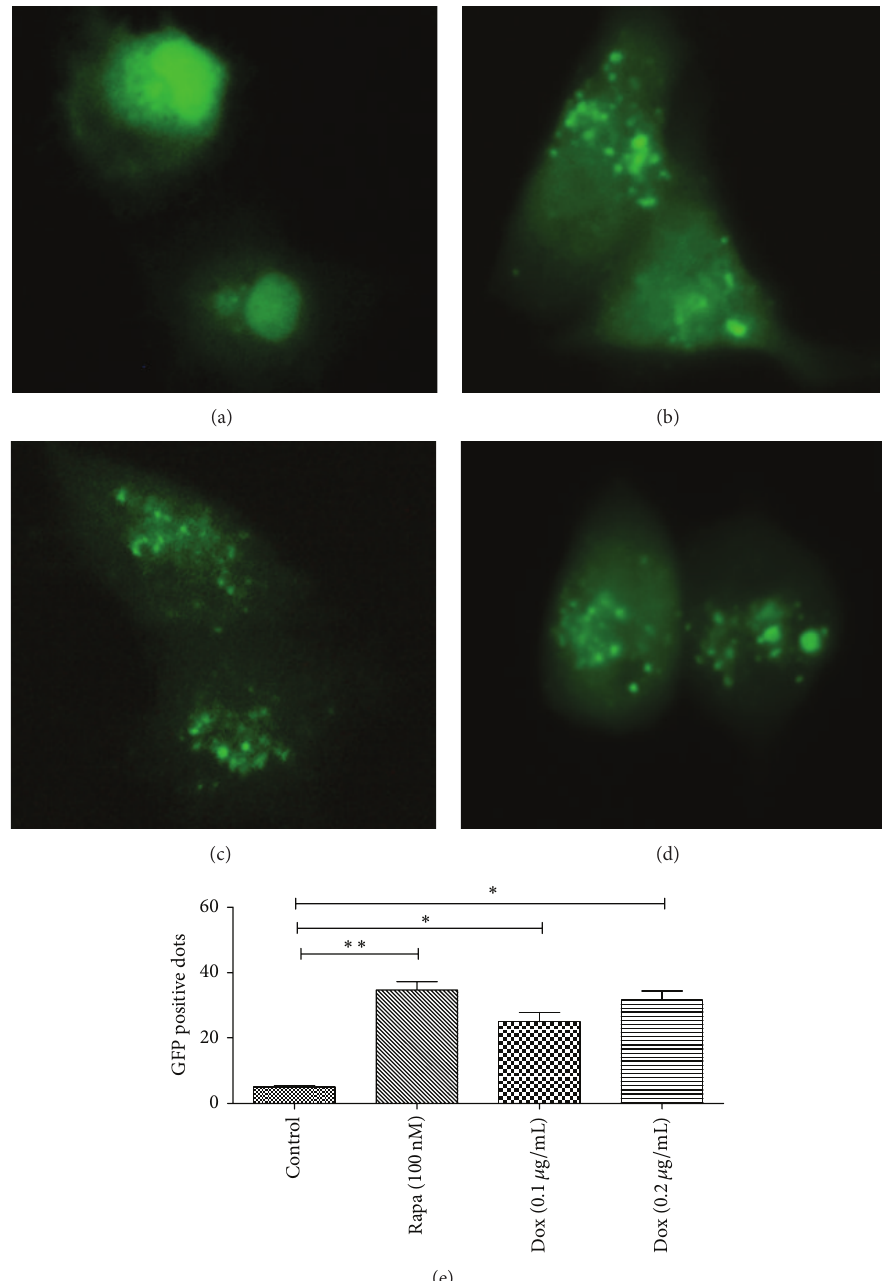
Figure 1: Dox promotes autophagic vesicles formation in U-2 OS cells. (a) Autophagic vesicles formation in negative control U-2 OS cells; (b) autophagic vesicles formation in U-2 OS cells which were treated with 100 nM rapamycin (positive control); (c) and (d) autophagic vesicles formation in Dox-treated U-2 OS cells (0.1 𝜇 g/mL (c) or 0.2 𝜇 g/mL (d)). Statistical significance shown as ∗ 𝑃 < 0.05 , ∗∗ 𝑃 < 0.01 . All experiments were independently performed at least for three